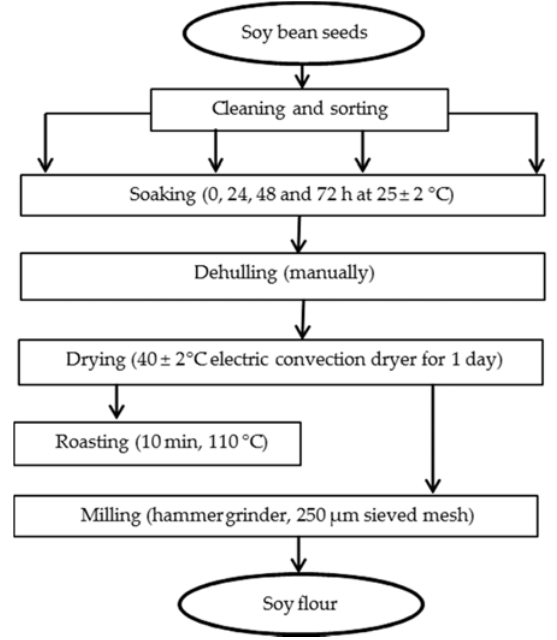
Figure 1. Flow diagram for the production of soybean flour.